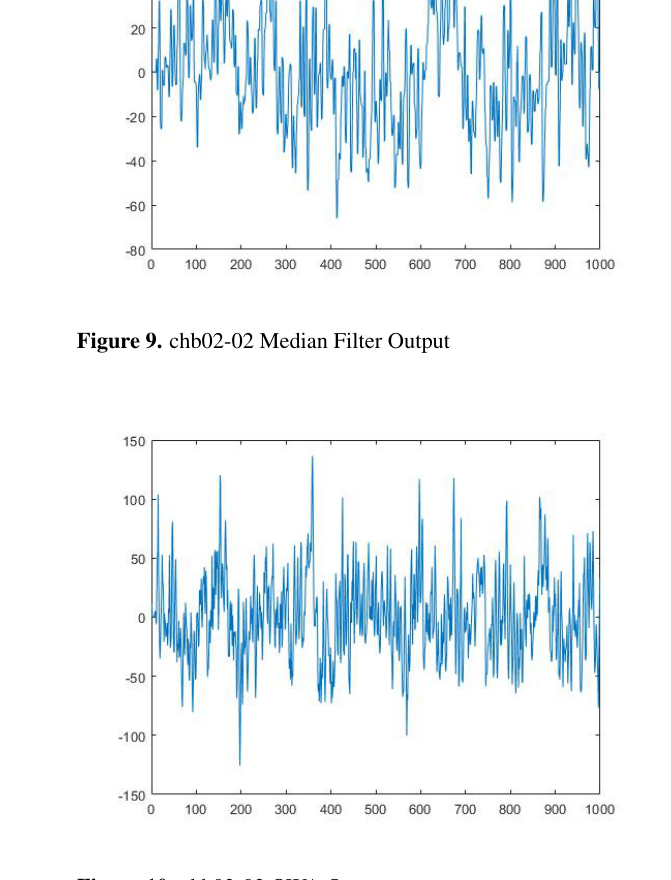
Figure 7. chb01-01 Median Filter Output